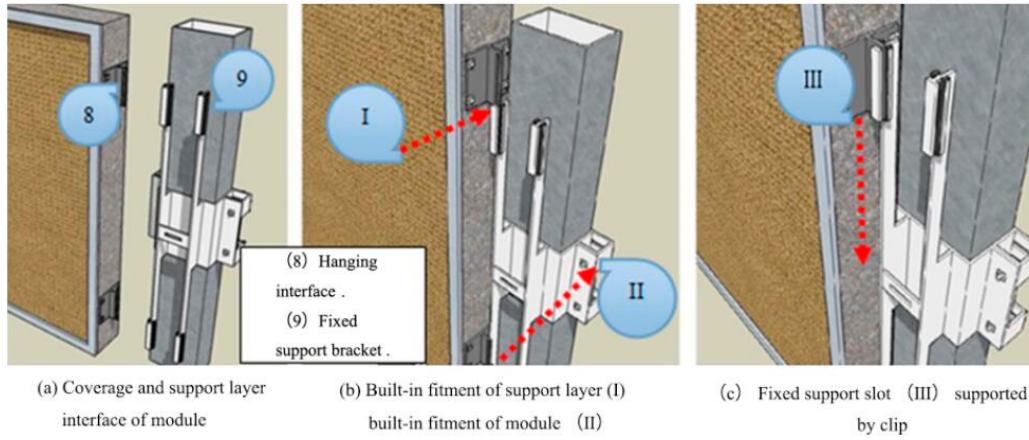
Figure 2. Installation process of modular solar building envelope.